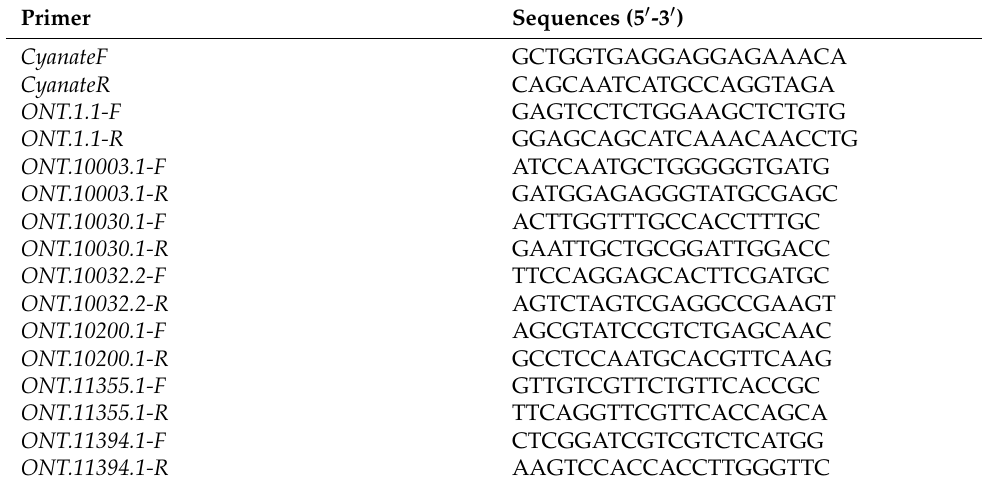
Table 1. Sequences of primers used in